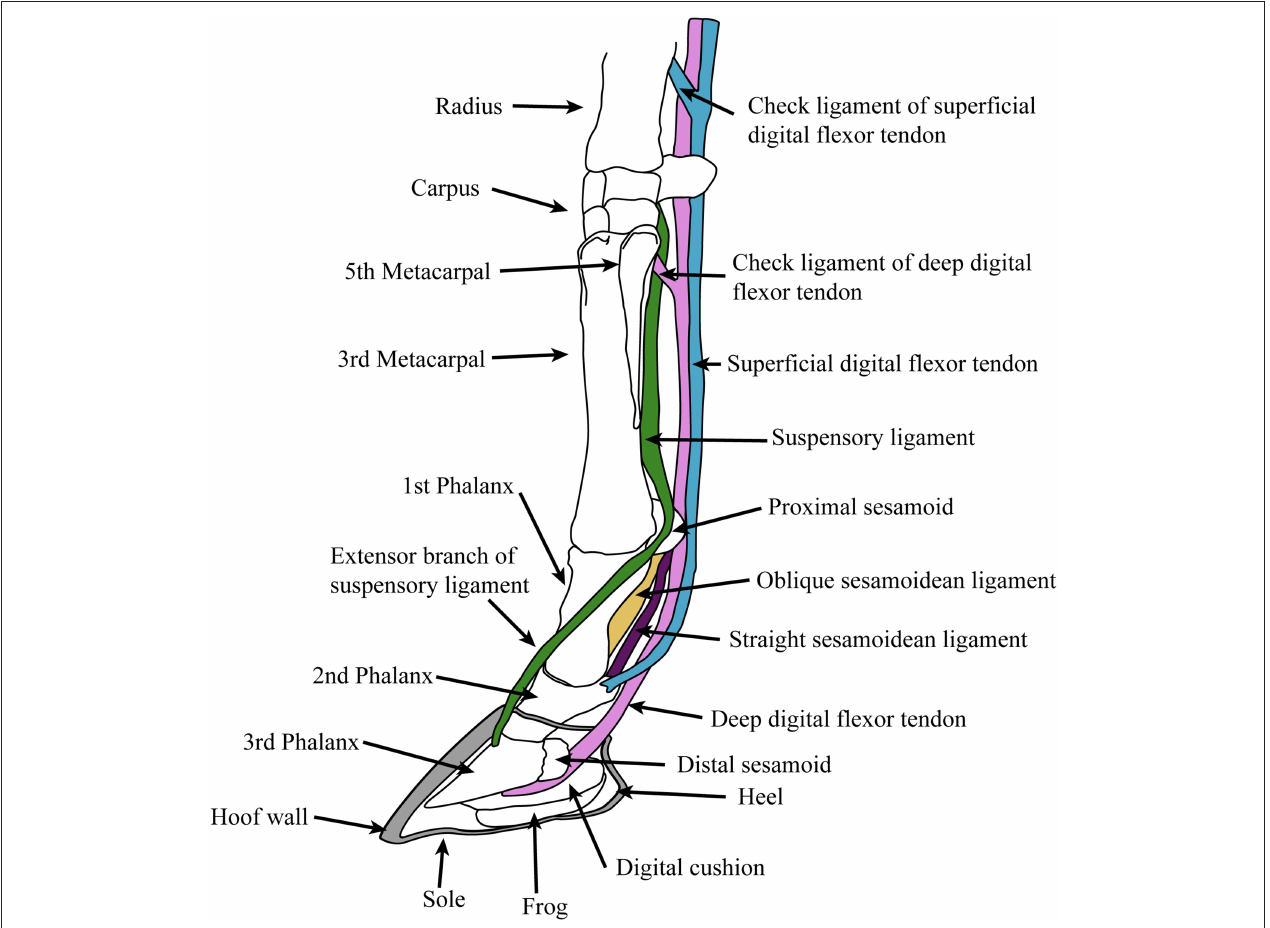
FIGURE 4 | Diagram of supportive tendons and ligaments of the equine foot (only selected ligaments, referred to in the text, are shown). The hoof (covering the third phalanx and the distal portion of the second phalanx) is shown in cross section. Original drawing by CMJ, final illustration rendered by James G.